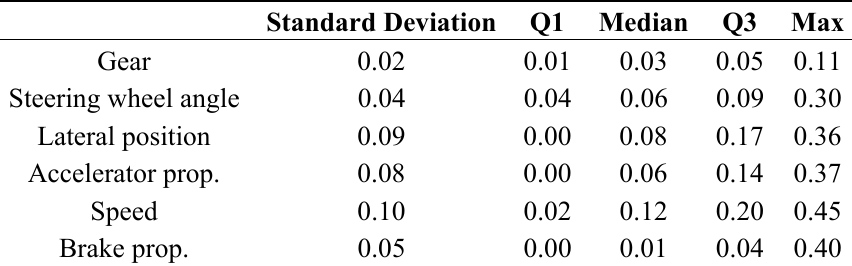
Table 10. Relevant characteristics for Expert